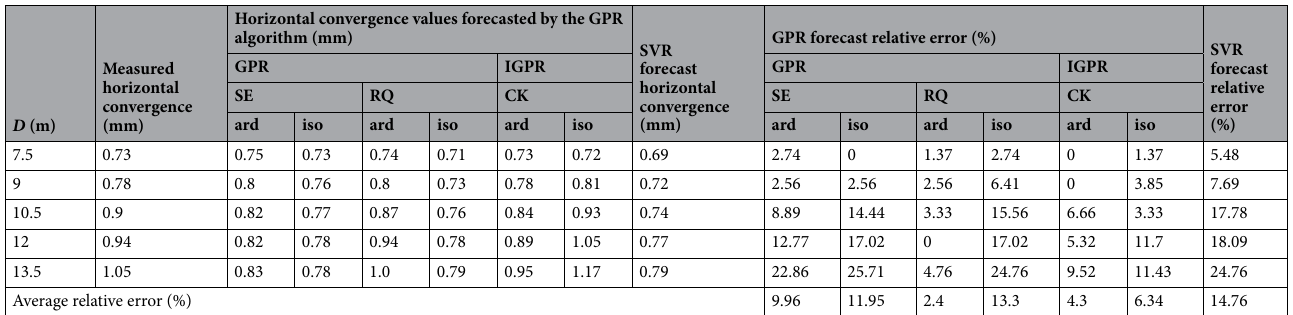
Table 9. Horizontal convergence values forecasted by the identified geomechanical parameters of monitoring section LK59 + 150.